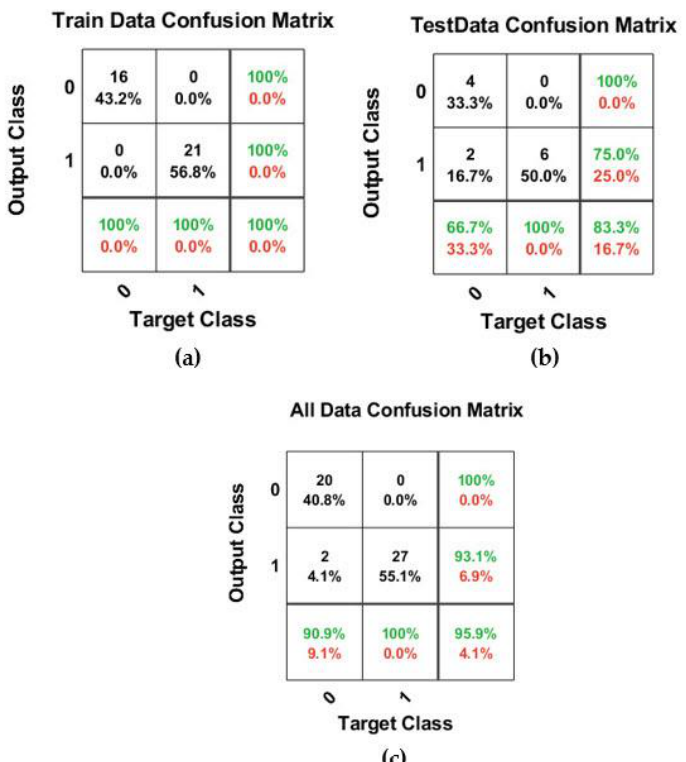
Figure 7. Results of the confusion matrix for training data ( a ), testing data ( b ), and total data ( c ) for k* 1.0 = 1.0.